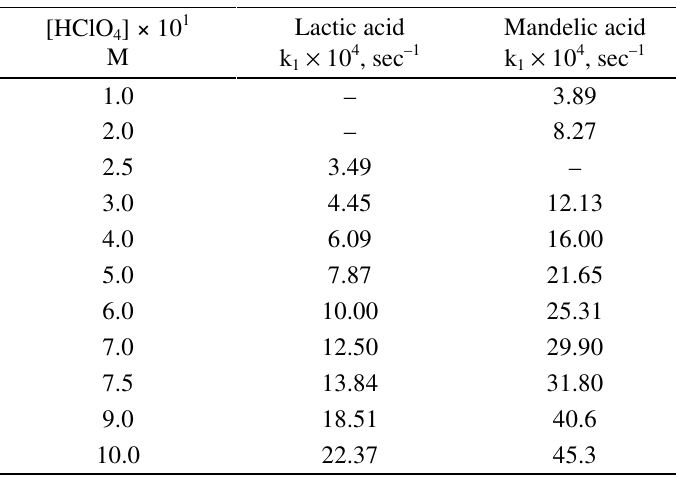
Table 3. Variation of rate with perchloric acid